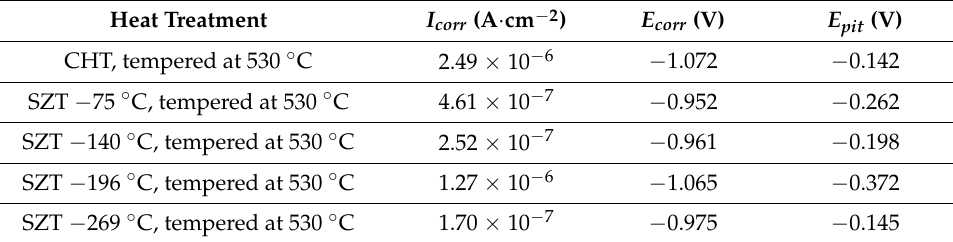
Figure 10. Potentiodynamic polarisation curves of CHT Vanadis 6 steel, and Vanadis 6 subjected to different SZTs, after tempering at 530 ◦ C. Table 6. Corrosion current, I corr , corrosion potential, E corr , and pitting potential, E pit , values acquired from corrosion tests in 3.5 mass % NaCl water solution, for CHT and different SZT specimens, after tempering at 530 ◦